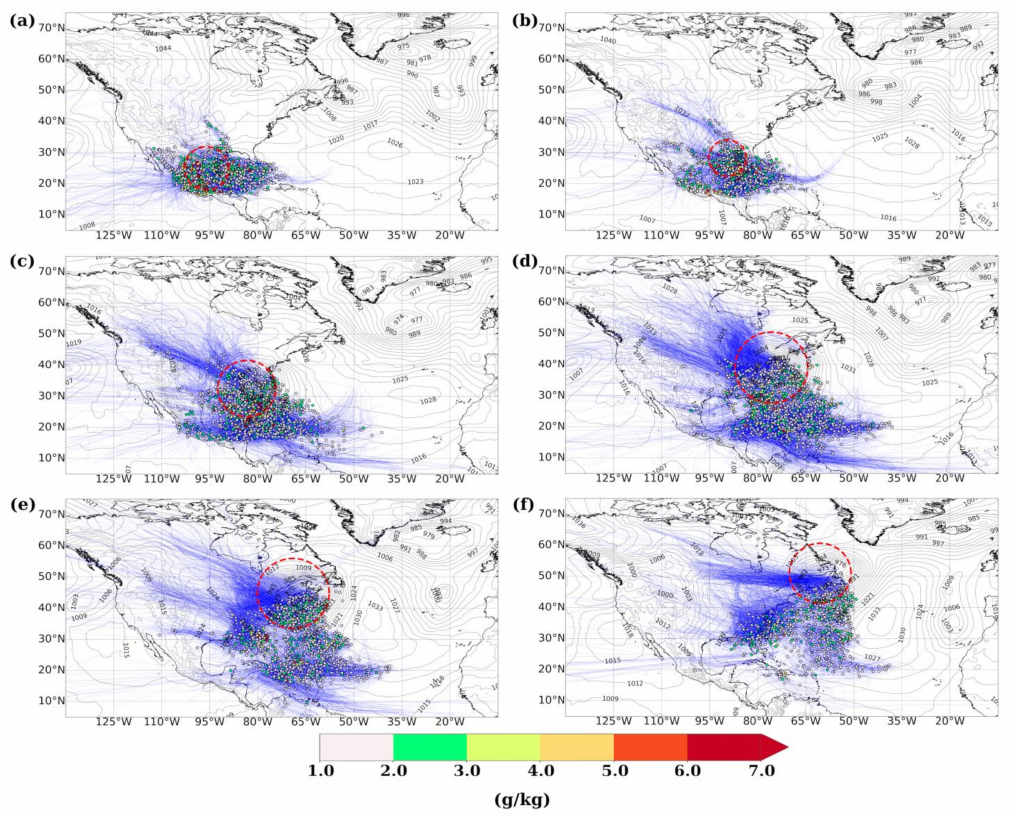
Figure 5. Trajectories associated with SC93 precipitation on ( a ) 12 March at 1200 UTC, ( b ) 13 March at 0000 UTC, ( c ) 13 March at 1200 UTC, ( d ) 14 March at 0000 UTC, ( e ) 14 March at 1200 UTC and ( f ) 15 March at 0000 UTC. Further shown are 6 h changes of specific humidity along trajectories (coloured dots). The mean sea level pressure (hPa) is also plotted in contours and the red-dashed line denotes the SC93